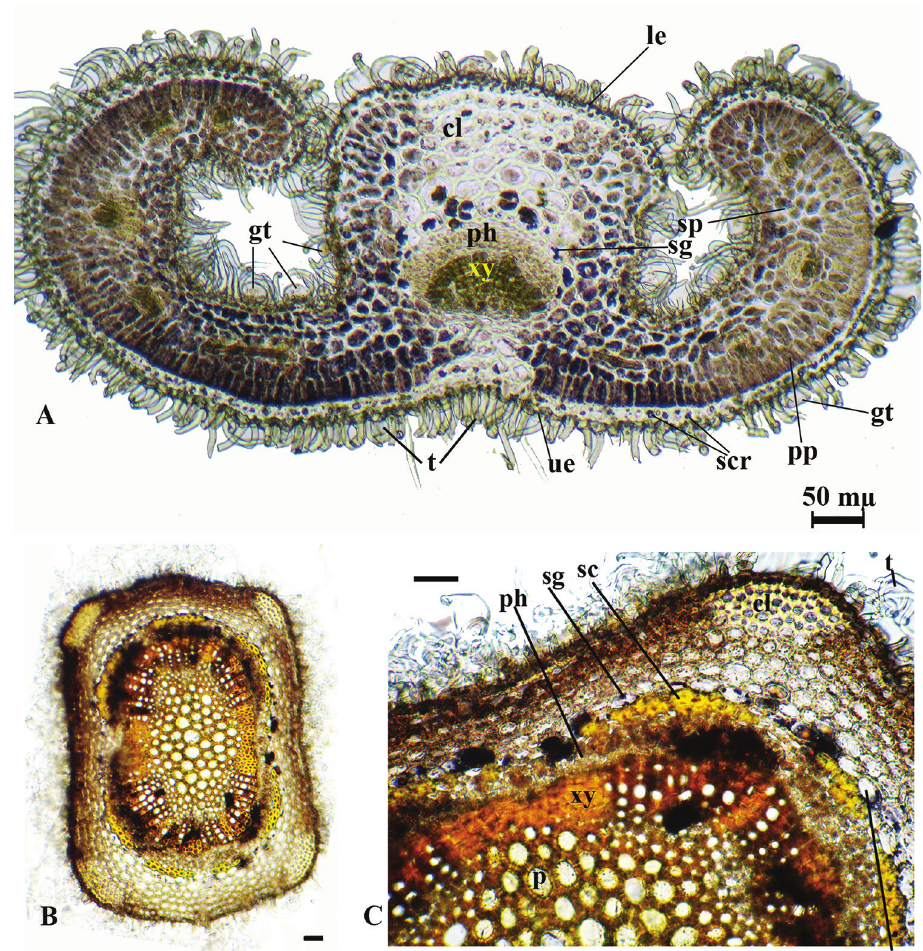
gt: glandular trichomes; le: lower epidermis; p: parenchyma; ph: phloem; pp: palisade parenchyma; sc: sclerenchyma; scr: sphaerocrystal, sg: starch grains; sp: spongy parenchyma; t: trichome; ue: upper epidermis; xy: xylem; Scale bars: 50